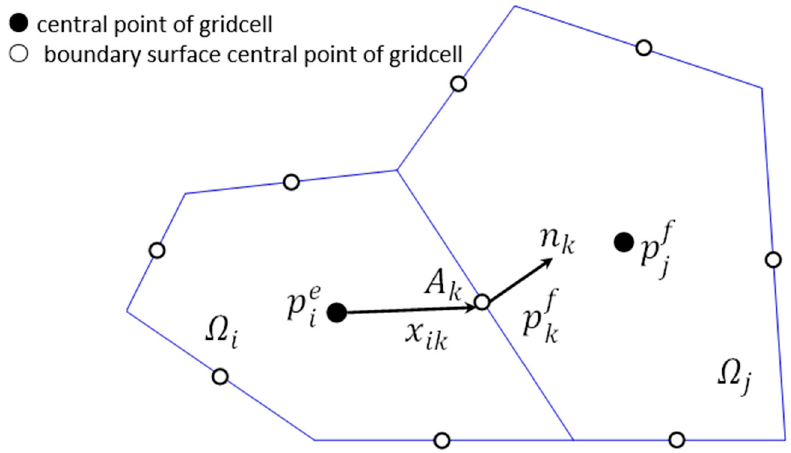
Figure 1. Schematic of grid analysis for mimetic finite difference method.